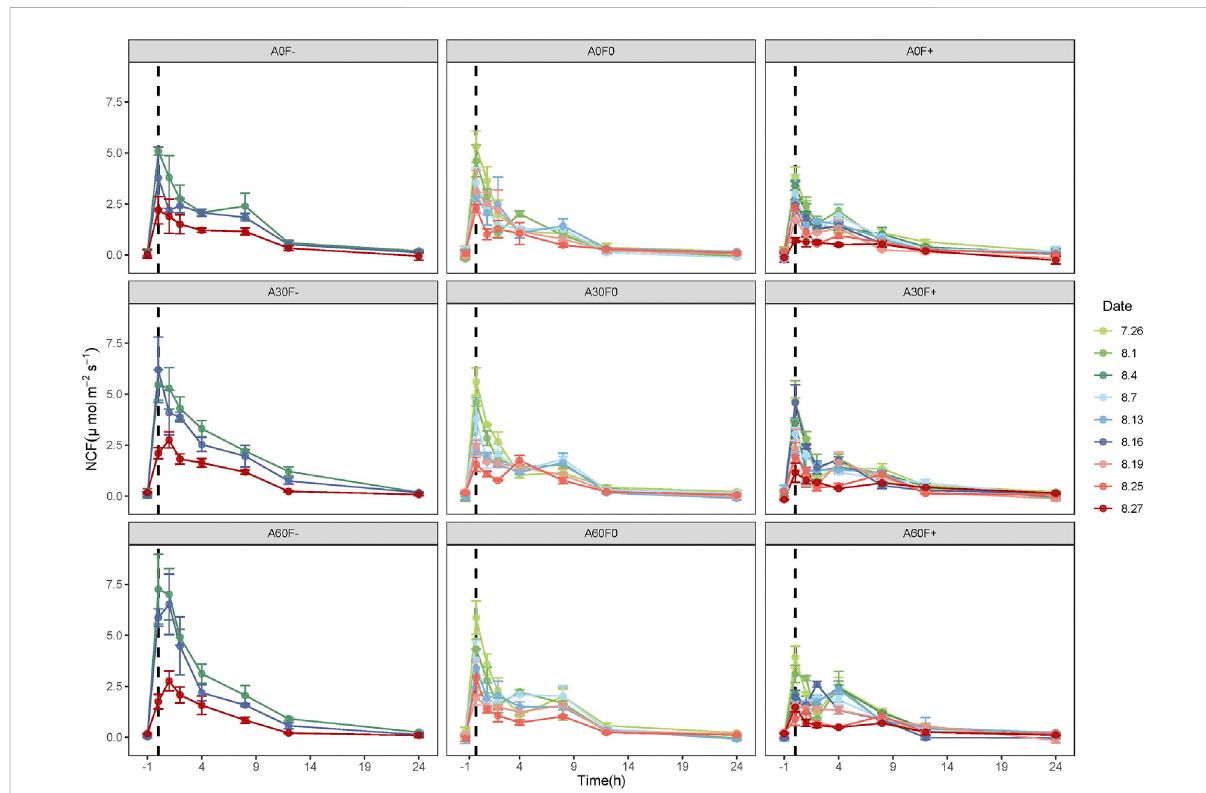
FIGURE 1 Dynamics of NCF in soil covered with cyanobacterial crust. -1 is the value determined before water application, and 7.26, and 8.1, etc., are the experimental dates. NCF: net carbon fl ux.